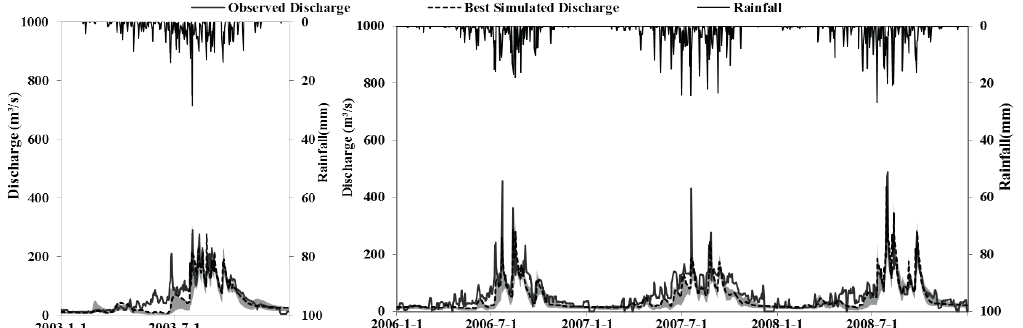
Fig. 3 Rainfall, observed and simulated discharge and 95PPU (shaded area) for calibration using river discharge data of year 2003 and validation period (2006–2008).